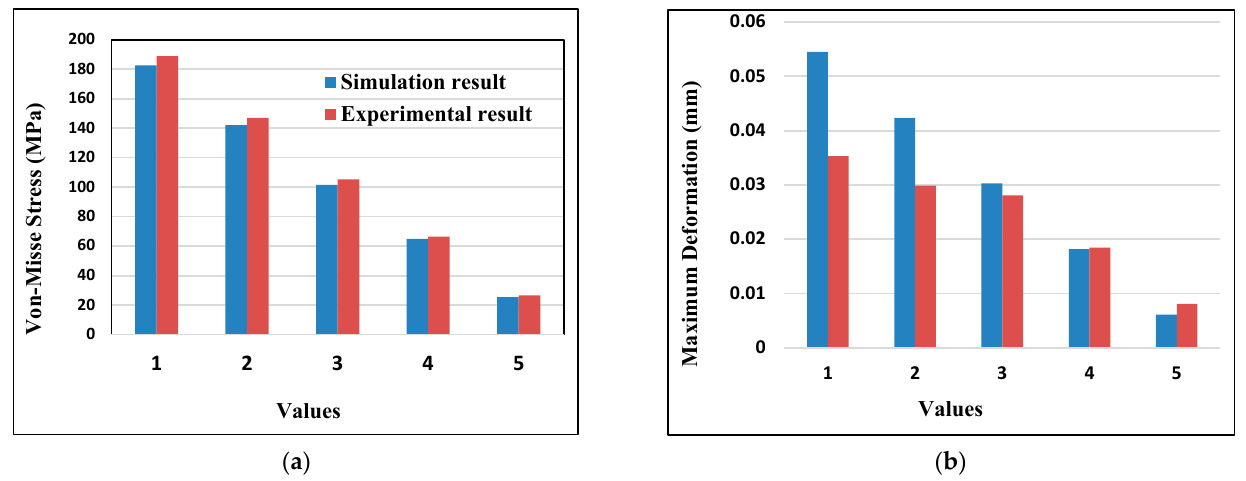
Figure 12. Variation of ( a ) von Mises stress and ( b ) maximum deformation value.